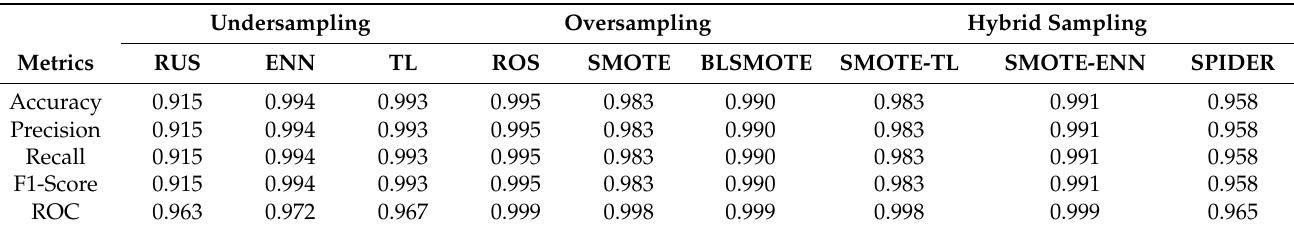
Table 7. Effect of resampling techniques on ANN classifier performance.